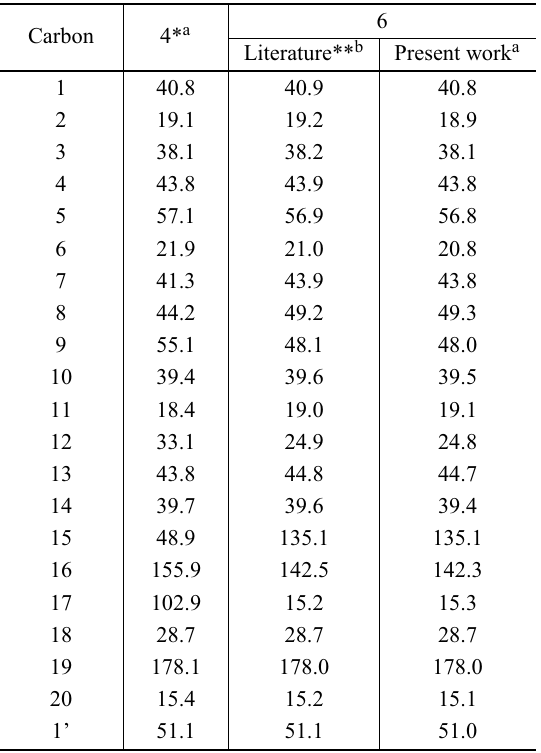
and methyl iso -kaurenoate ( 6